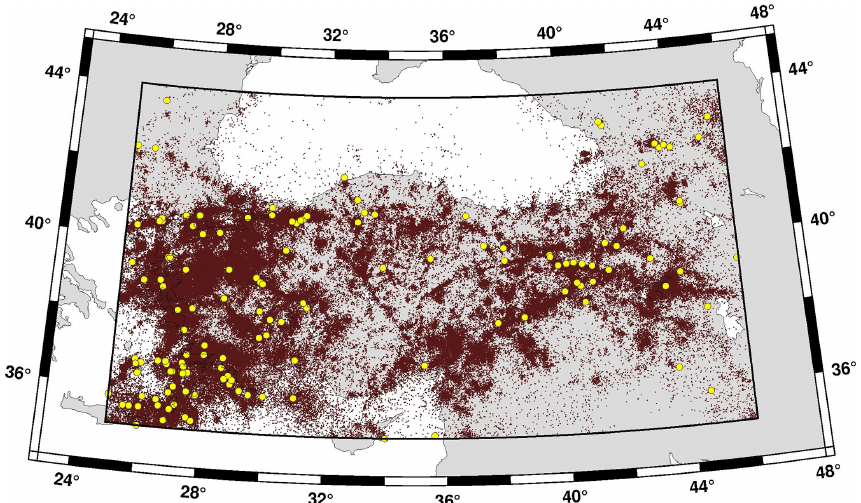
Figure 3. The earthquakes in the homogenized catalogue (dots). Yellow circles are the events with an equivalent moment magnitude ( M ∗ w ) greater than 6.0 (total 145 events).